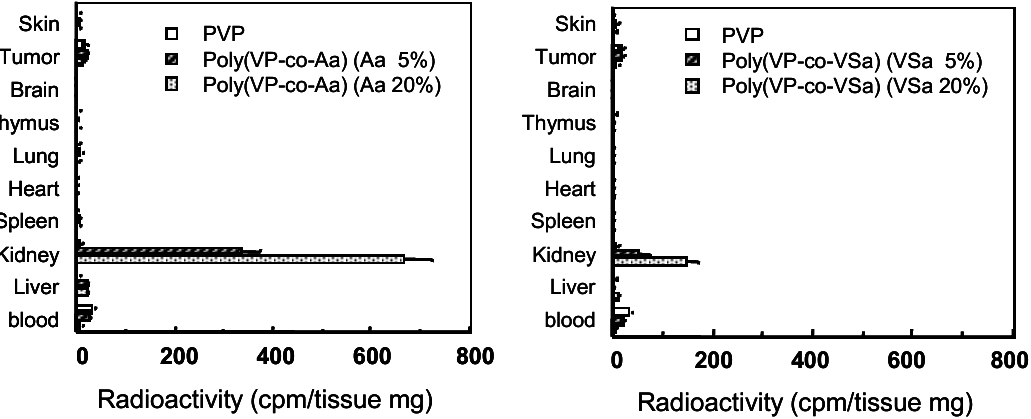
Figure 6. Tissue distribution of PVP and anionized PVP derivatives at 3h after i.v. injection in mice. Mice were intravenously injected with 125I-labeled polymers. After i.v. injection, mice were killed and the organs were collected. The radioactivity was measured by γ -counter. Mice were used in groups of five. Each value is the mean ±